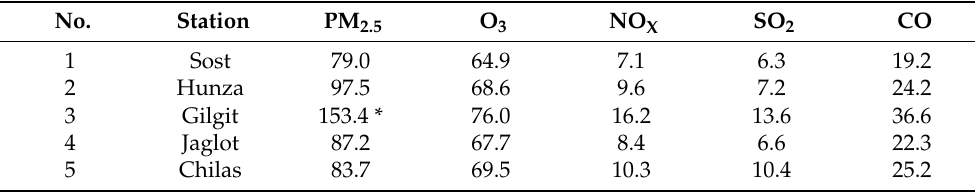
Table 5. AQI values for selected analytes in winter, 2019.